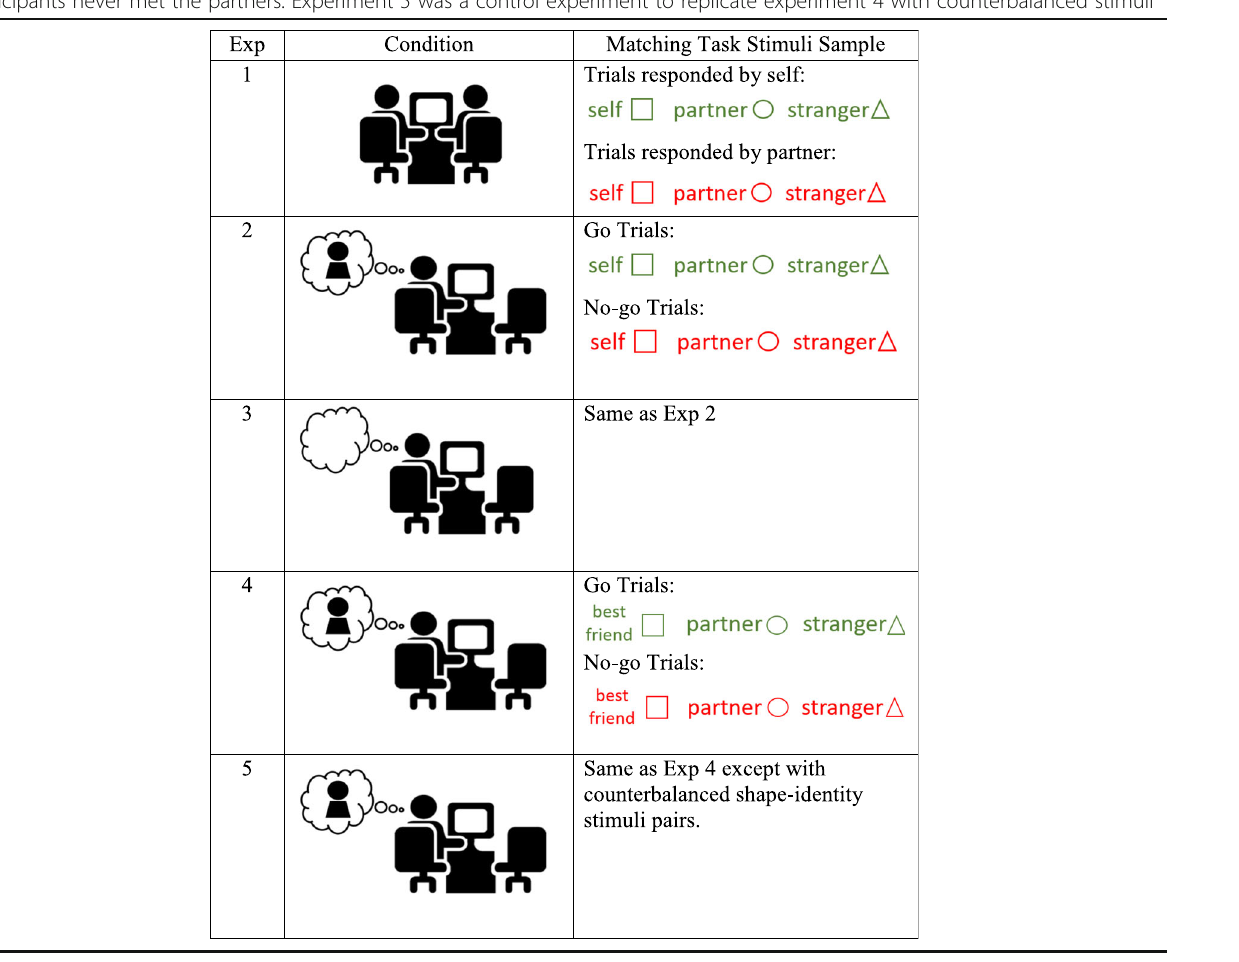
Table 1 Experimental conditions and matching task. In experiment 1 (the joint condition), two participants performed the task on separate keyboards. Each participant responded only to their assigned color (red or green) in the task (go trials). In this example, their names and a neutral name were assigned to correspond to three shapes (square, triangle, and circle), which participants had to memorize for the name-shape matching task. In experiments 2, 3, 4, and 5 (individual condition), the other participant waited outside the room. Similarly, participants responded only to their assigned color (go trials) but not the other color (no-go trials). In experiments 2, 4, and 5, the participants briefly met the partners without any verbal communication, while in experiment 3,